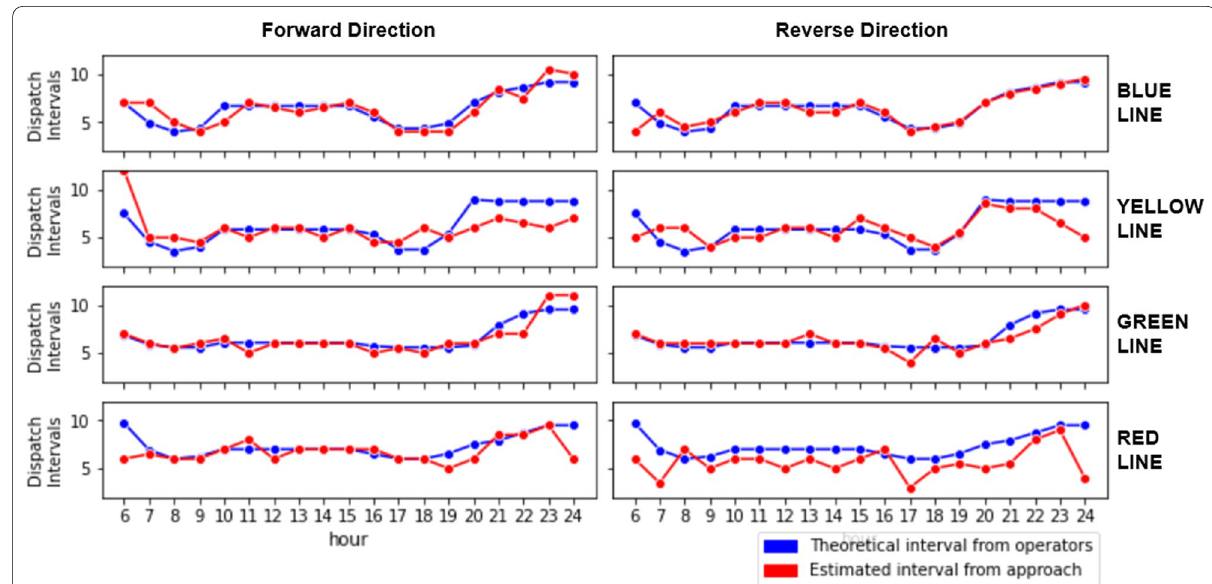
Fig. 9 Average train dispatch intervals: comparison of estimated and theoretical values across different lines and hours of the